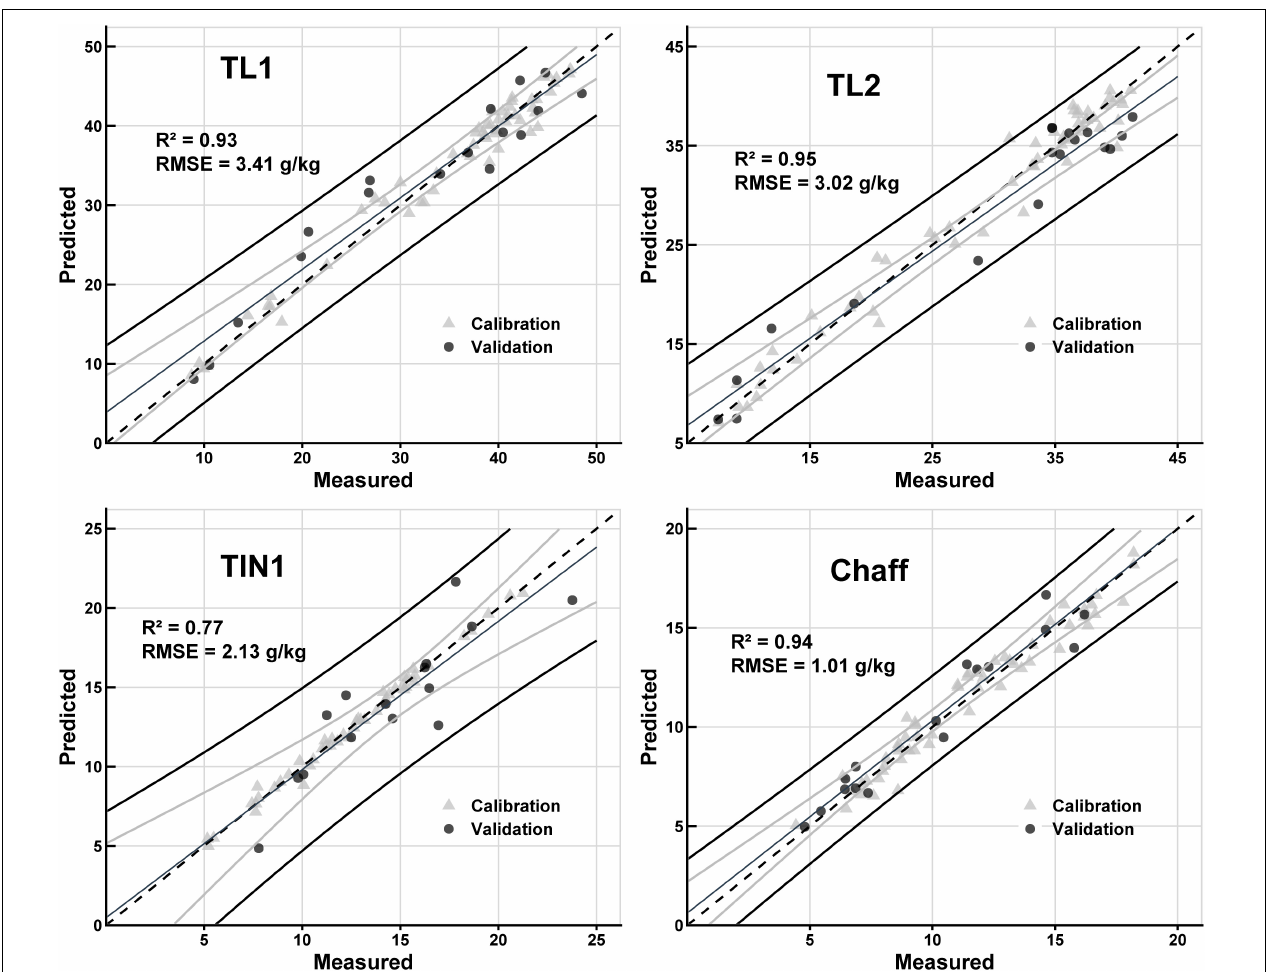
FIGURE 3 | Results of PLSR predictive models for nitrogen concentration ( N mass ). Comparison between measured N mass and predicted N mass for organs of TL1, TL2, TIN1, and Chaff. In the figures, calibration (gray triangle) and validation (solid circle) data points are illustrated. The dashed line shows 1:1 line, the fine black line shows regression line, the black lines show 95% prediction interval, and gray lines show 95% confidence interval of the validation dataset. Statistic parameters ( R 2 and RMSE) for the validation datasets are shown in the plots.